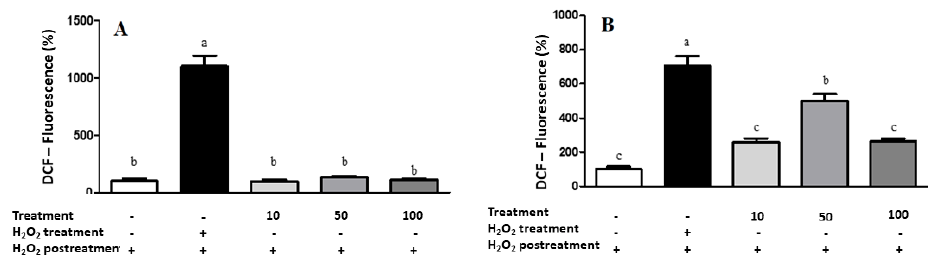
Figure 6. Results of intracellular ROS measurement in A549 ( A ) and IMR90 ( B ) cells by spectrofluoremetry. Treatment = lyophilized marigold extract ( C. officinalis ) at 10–100 µg/mL. Quantitative data are the mean ± standard deviation. Different letters (a–c) comparing the treatments indicate significant differences ( p < 0.05).